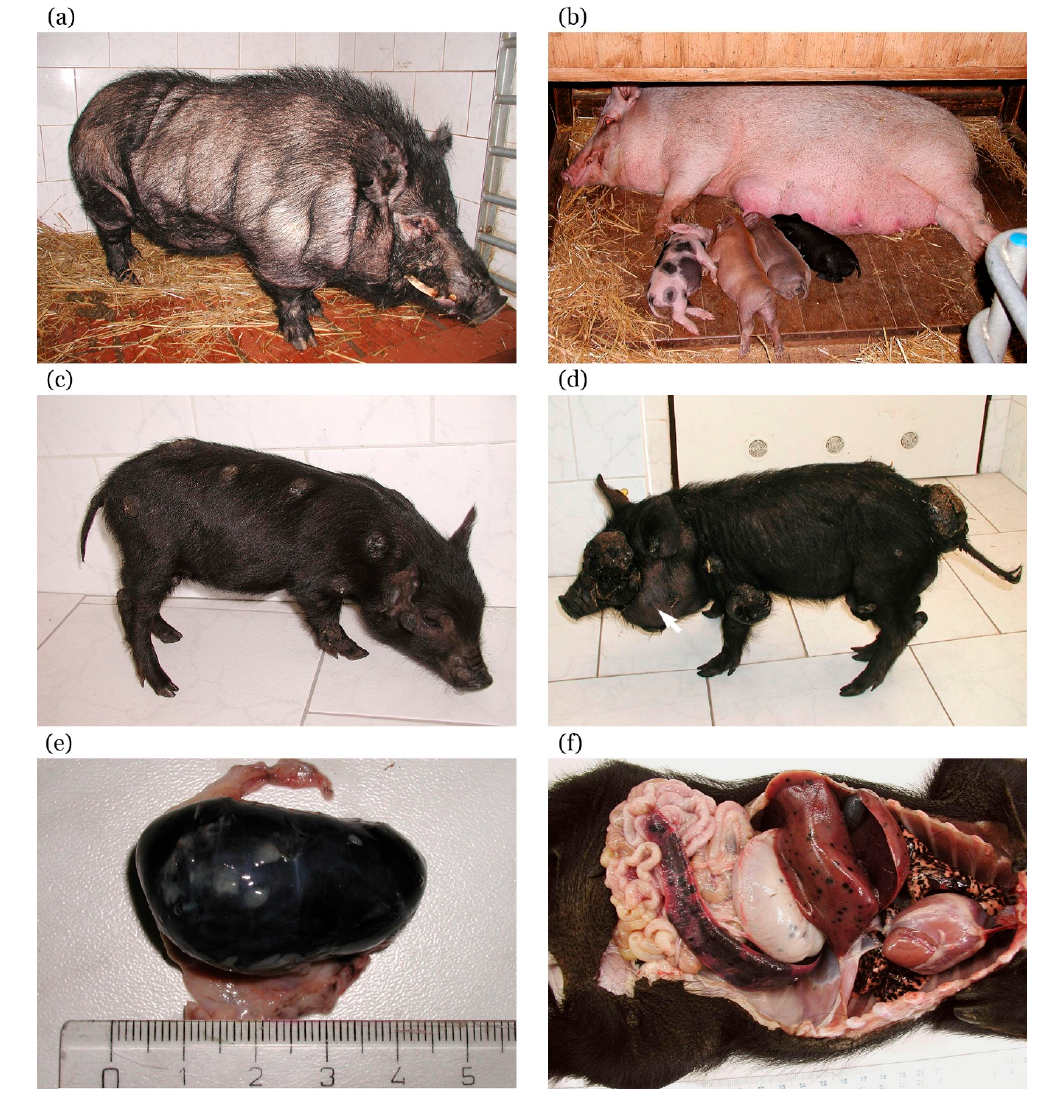
Figure 2. Melanoma-bearing Libechov minipig (MeLiM) swine model of hereditary melanoma: ( a ) black boar of the MeLiM strain after spontaneous regression of melanoma (without any changes in pigmentation) (age three years); ( b ) originally black sow of the MeLiM strain (age four years) after spontaneous regression of melanoma (with almost total depigmentation), together with piglets of different coat color (age three weeks); ( c ) MeLiM piglet with multiple cutaneous nodular melanomas (age six weeks); ( d ) MeLiM piglet showing several large nodular melanomas with local necrosis and beginning cachexia (age seven weeks). Note the vastly increased cervical lymph node (arrow) due to melanoma metastasis; ( e ) very enlarged inguinal lymph node totally infiltrated by metastatic melanoma cells (taken from MeLiM piglet with melanoma progression, age six weeks), scale in cm; ( f ) autopsy of MeLiM piglet that died from melanoma progression (age four weeks). Numerous melanoma metastases (seen as black spots) in visceral organs (lungs, liver, stomach, and spleen) clearly document the malignant characteristic of melanoma in the MeLiM model.